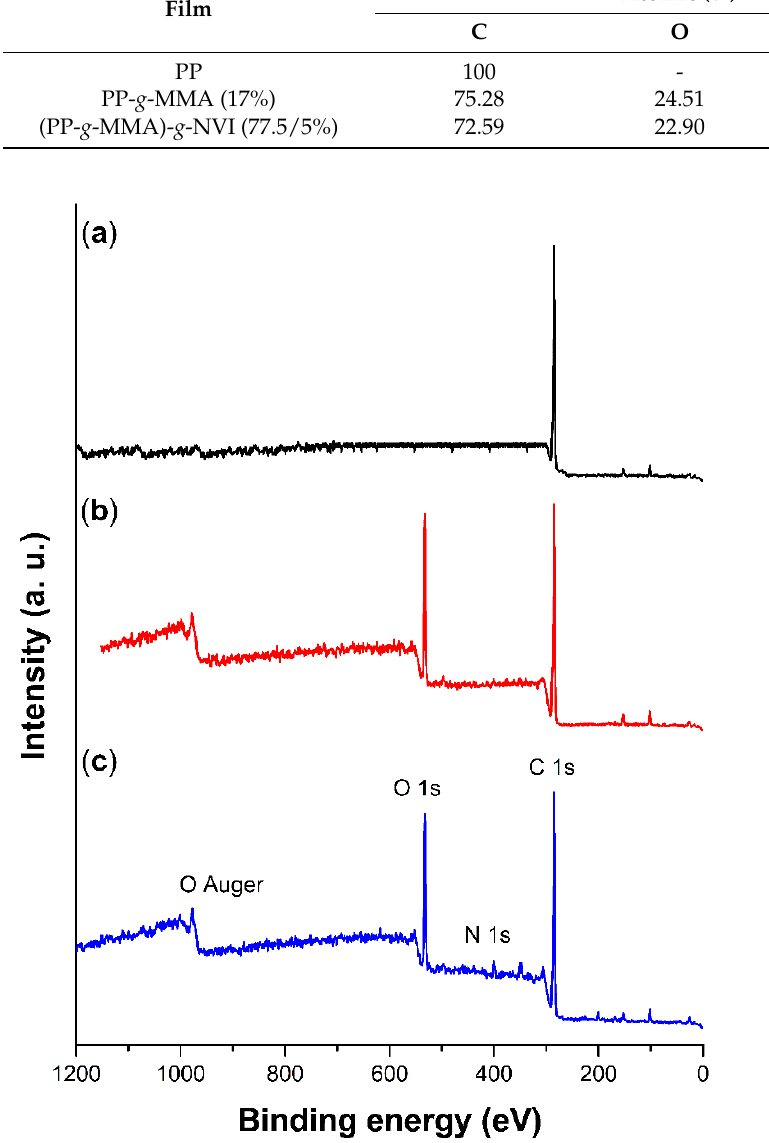
Figure 5. XPS scan of: ( a ) non-irradiated PP, ( b ) PP- g -MMA (17%), and ( c ) (PP- g -MMA)- g -NVI (77.5/5%).